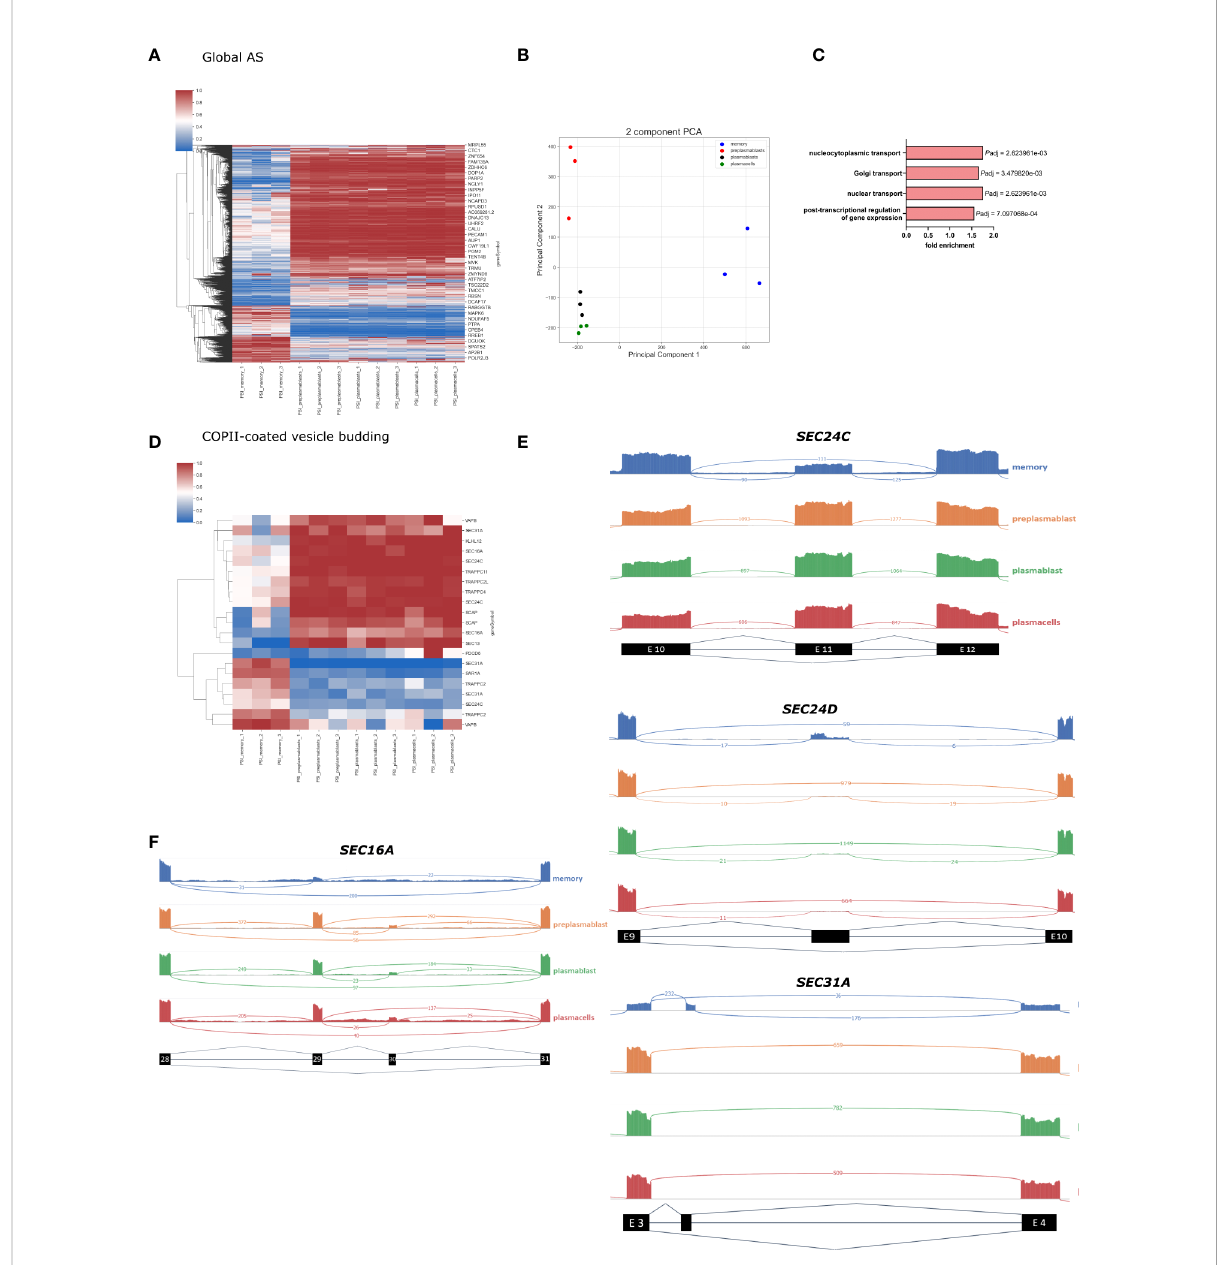
FIGURE 3 Global splicing analysis in B-Cell differentiation. (A) Heatmap showing the PSI of all signi fi cantly altered splicing events in B-cell populations ( P- value < 0.001, DPSI > |0.4|). (B) PCA of all annotated splice events in B-cell differentiation. (C) Enriched GO terms in AS genes in MBC; only the GO terms related to intracellular transport are shown. P -adjusted values (FDR). (D) Heatmap showing all signi fi cant PSI changes for splicing events in genes in the GO-term “ COPII vesicle coat ” . (E) Sashimi plots for selected frameshift splice events in COPII compartments. (F) Sashimi plot showing splicing of SEC16A Exon 29 and